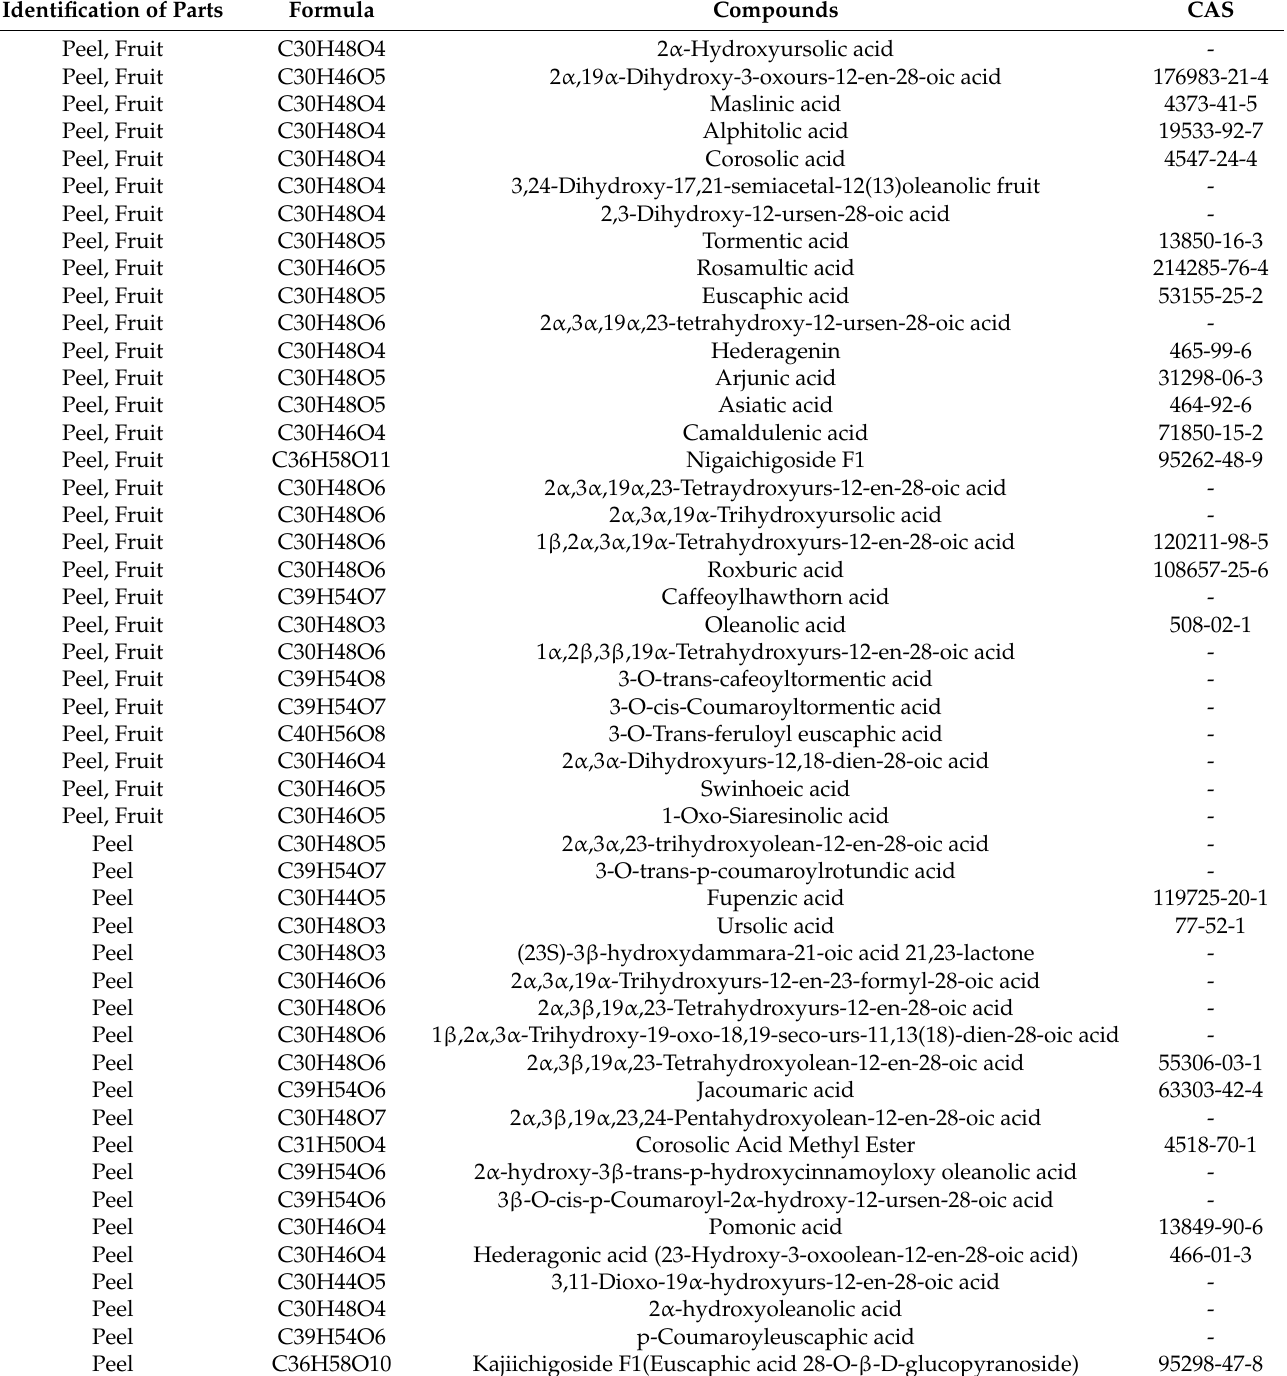
Table 5. Qualitative analysis by